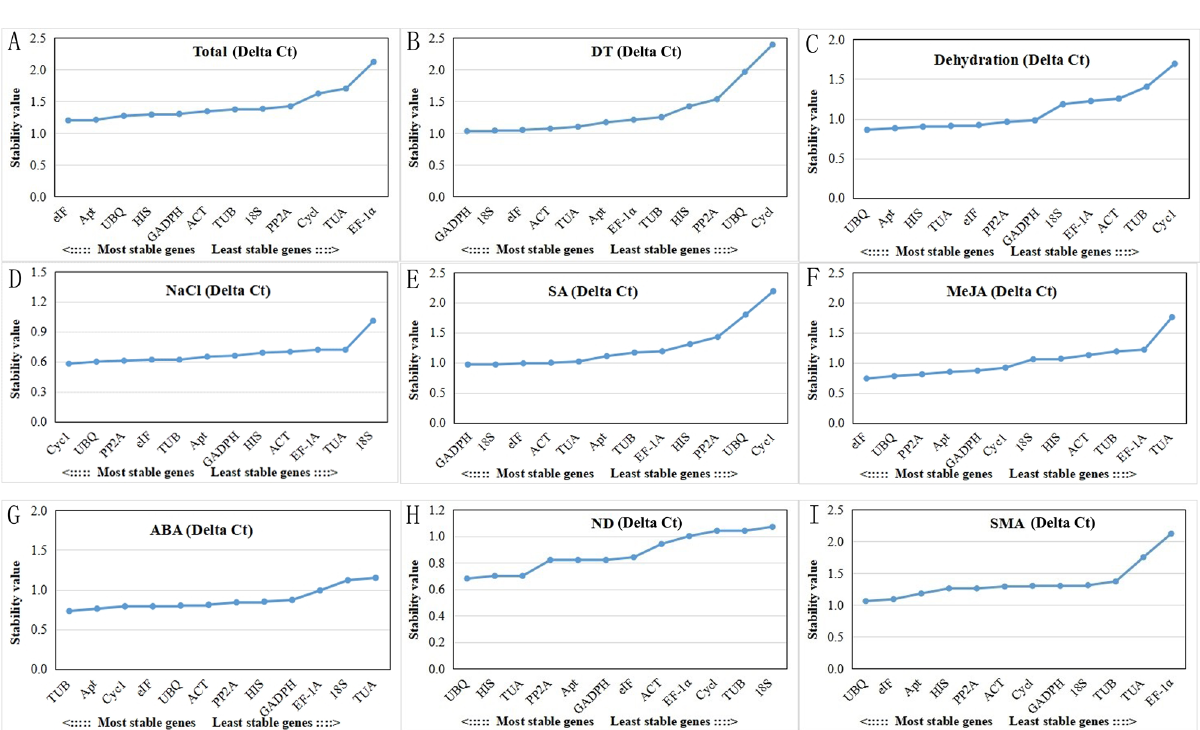
Figure 3. Candidate reference gene ranking based on ∆Ct method. ( A ) Total: the set of total samples. ( B ) DT: the set with the samples of different tissues. ( C ) Dehydration treatment samples. ( D ) NaCl treatment samples. ( E ) SA treatment samples. ( F ) MeJA treatment samples. ( G ) ABA treatment samples. ( H ) ND: the set with the samples of NaCl and dehydration treatments. ( I ) SMA: the set with the samples of SA, MeJA, and ABA